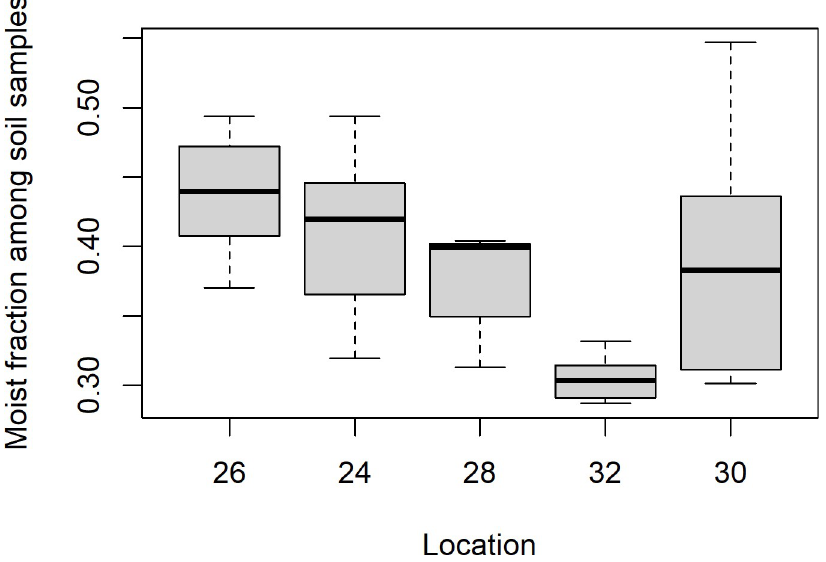
Fig 6. Boxplot of moist fraction of soil samples among localities within Mining